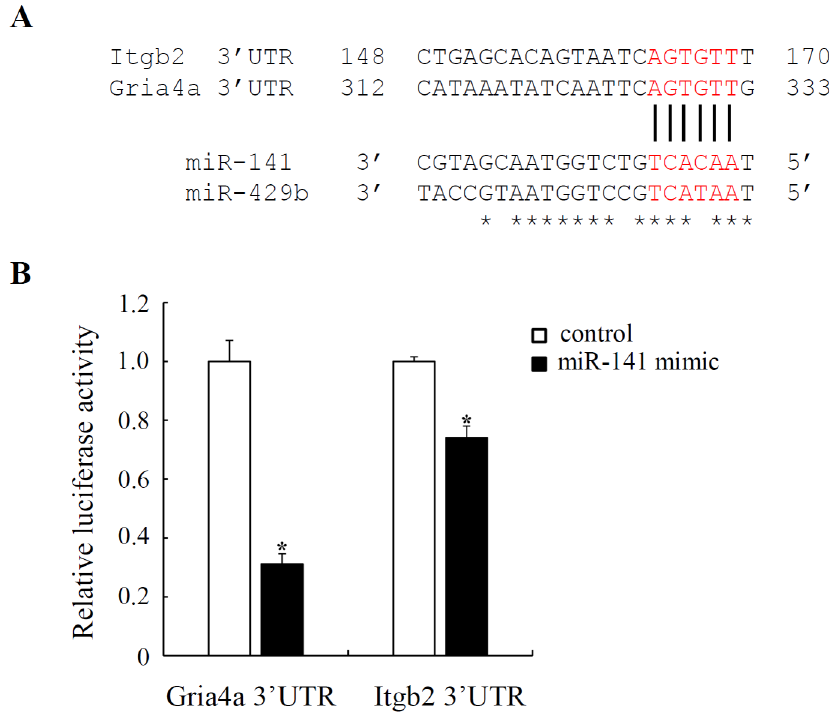
Fig 8. Itgb2 and Gria4a are targets of miR-141. (A) Sequence alignment of Itgb2 and Gria4a 3 ’ UTR to miR- 141/-429b. Red color letters represent seed sequences of miR-141/-429b and their binding positions. (B) The activities of pmirGLO reporters that is linked to the 3 ’ UTR of Itgb2 and Gria4a were suppressed by miR-141 when compared to its control oligonucleotide. * p < 0.05 indicates the significant